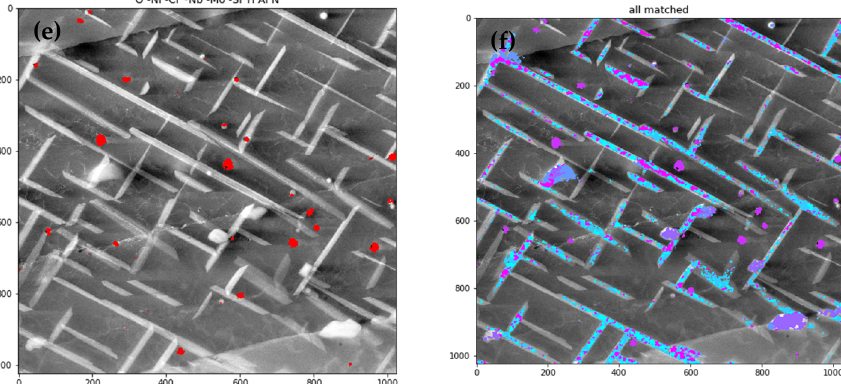
Figure 13. The overlay images of STEM-HAADF and regions identified as phases groups 1–5 marked in red ( a – e ), and regions identified as any phase group marked in violet-blue ( f ). Table 5. Phases groups. Sign ‘-‘ indicates “not increased”, no sign indicates “increased”, and ‘*’ sign indicates “not relevant”.